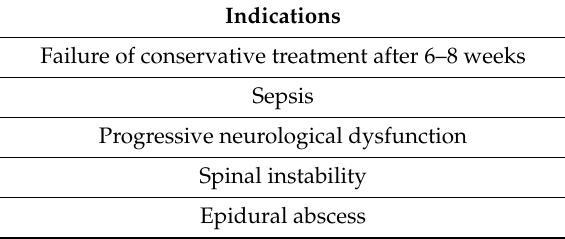
Table 3. Indications for surgical